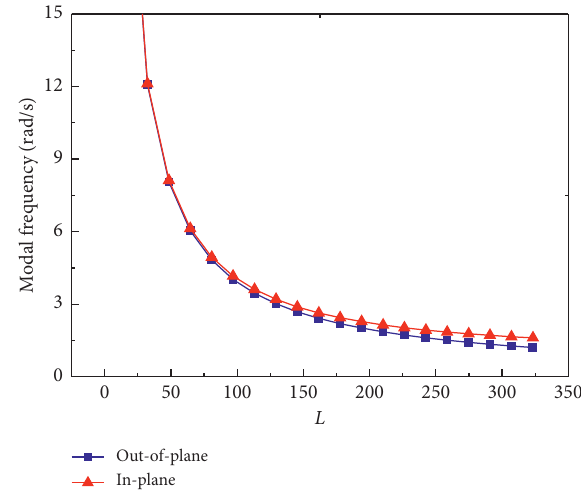
Figure 13: Relationship between first order modal frequency and length of